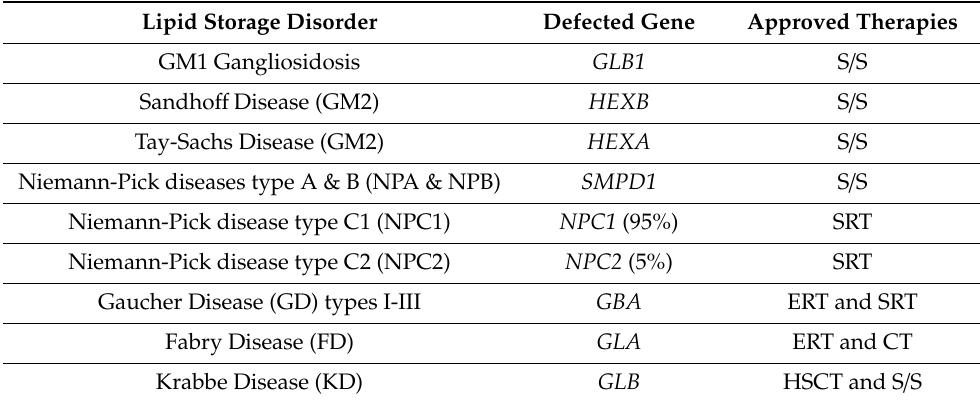
Table 1. Gene defects and approved therapies for lipid storage